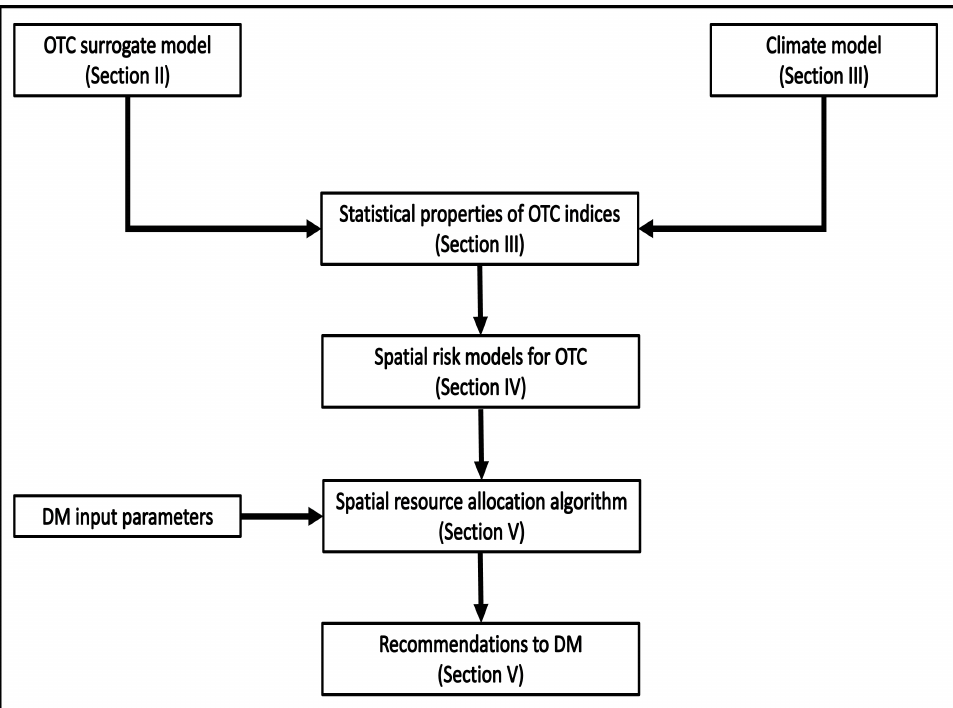
Figure 1. A graphical illustration of the spatial risk and resource allocation system